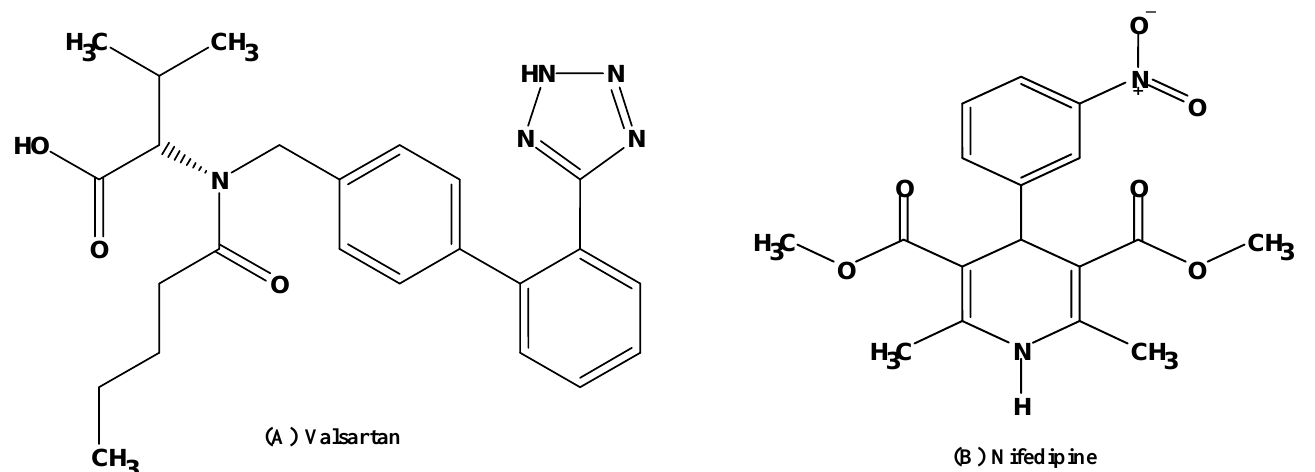
Figure 1. Chemical structure of: ( A ) Valsartan ((2S)-3-methyl-2-[pentanoyl-[[4-[2-(2H-tetrazol-5yl) phenyl]phenyl]methyl]amino] butanoic acid, MW = 435.5). ( B ) Nifedipine (dimethyl 2,6-dimethyl-4-(2-nitrophenyl)-1,4-dihydropyridine-3,5-dicarboxylate, MW = 346.3). Val induces its action by antagonizing the renin-aldosterone system (RAAS), which is where it competes with angiotensin-II to bind to the type-1 angiotensin II